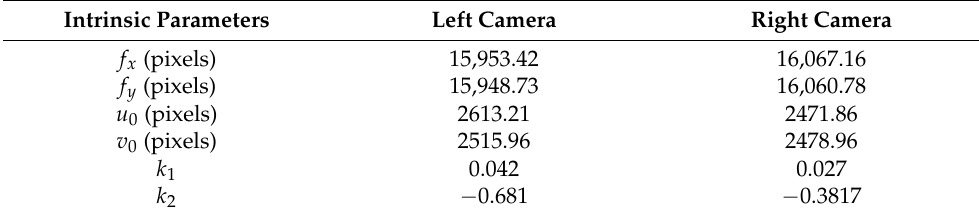
Figure 13. Outdoor experimental setup. Table 4. Intrinsic parameters of the stereo vision system predetermined with Zhang’s